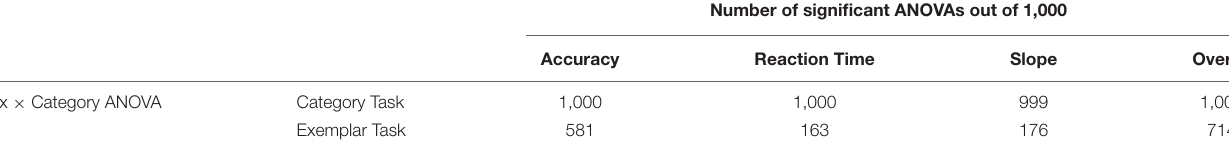
TABLE 4B | Power Analysis, scenario (ii): reversed difference between faces and interests in ASD